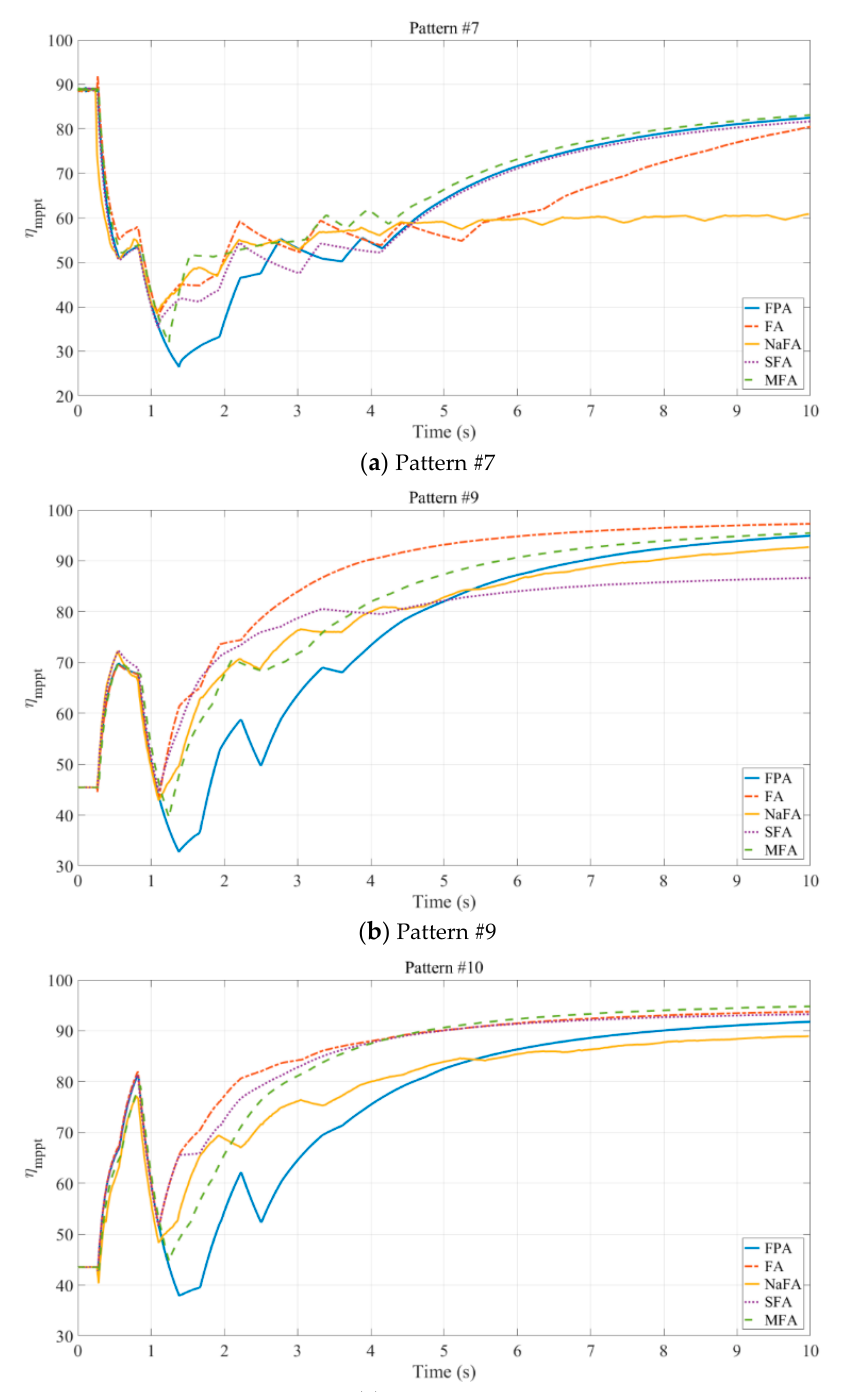
Figure 21. Efficiency variations during one evaluation tracking process of the five algorithms under Patterns #7, #9, and #10.